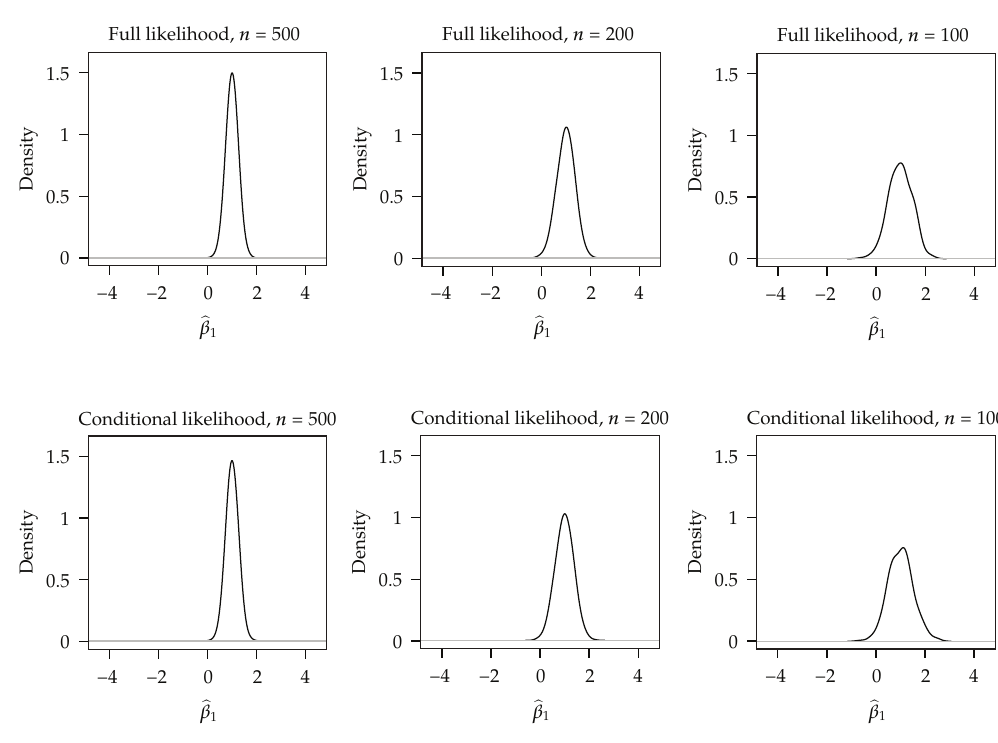
Figure 7: Sampling distributions for maximum likelihood estimates of regression coe ffi cient β 1 from 1000 replications; normal model fitted to normal data (cid:5) Y i ∼ Z i (cid:9) N (cid:5) 4 , 4 (cid:6)(cid:6)